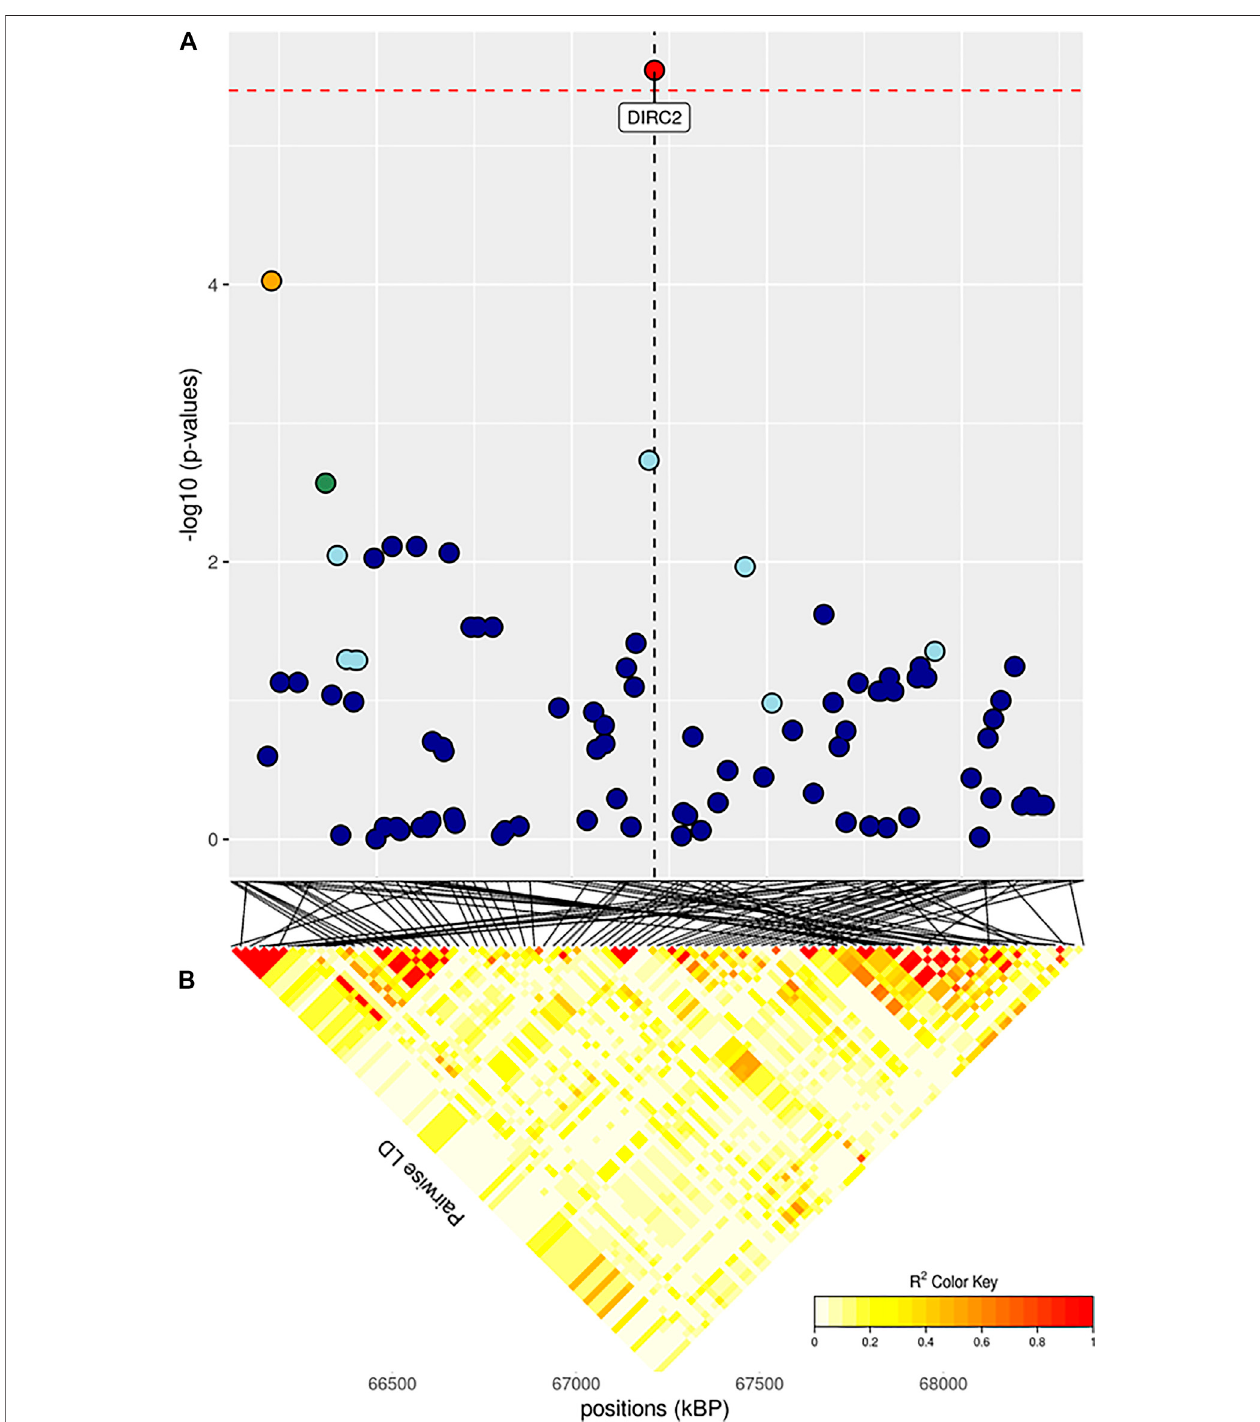
FIGURE 4 | (A) Localized linkage disequilibrium analysis of ADG_i. Manhattan plots displaying the level of signi fi cance (y-axis) over genomic positions (x-axis) in a window of 0.5 Mb upstream and downstream of the most signi fi cantly SNP. Vertical line represents the position of candidate gene DIRC2 . Different colors are used to represent the pairwise LD with the closest signi fi cant SNPs: blue < 0.2; light blue < 0.4; green < 0.6; yellow < 0.8 and red > 0.8. (B) Represents linkage disequilibrium of that area.